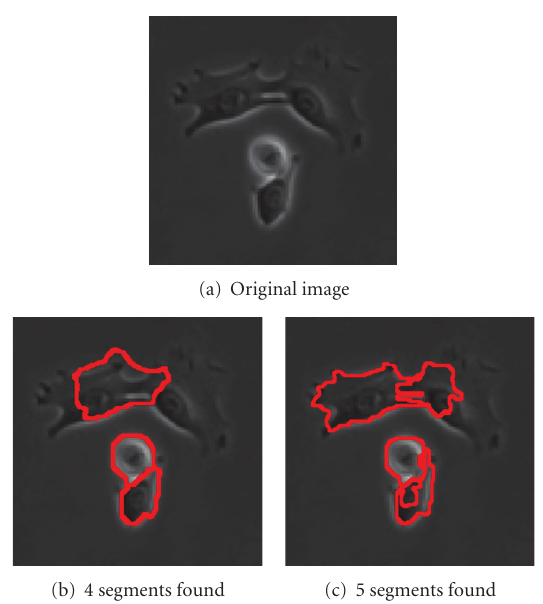
Figure 11: Parameters used: (b) n = 120, α = 50, (cid:7) α = 0, β = 110, θ = 0 . 15, γ = 1 . 5, d 1 = 0 . 15, σ = 5, ρ = 1; (c) n = 120, α = 100, (cid:7) α = 0, β = 110, θ = 0 . 11, γ = 0 . 9, d = 0 . 15, σ = 5, ρ = 1